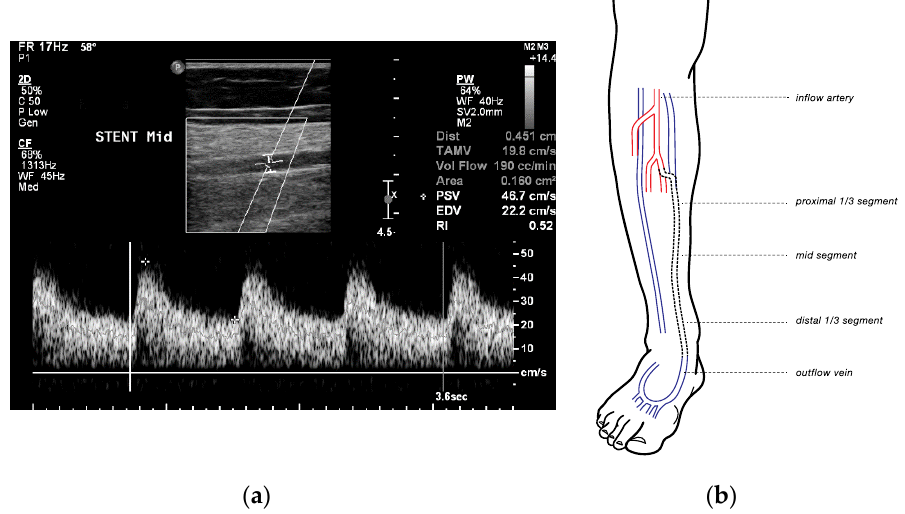
Figure 1. Image of duplex ultrasound measurement and measurement points. ( a ) Duplex ultrasound image of measuring the volume flow in the mid-segment of the stented vein. ( b ) Schematic image of the various duplex ultrasounds measuring points in patients after percutaneous deep venous arterialization. Measurements consisting of diameter, PSV, and volume flow, were recorded at 5